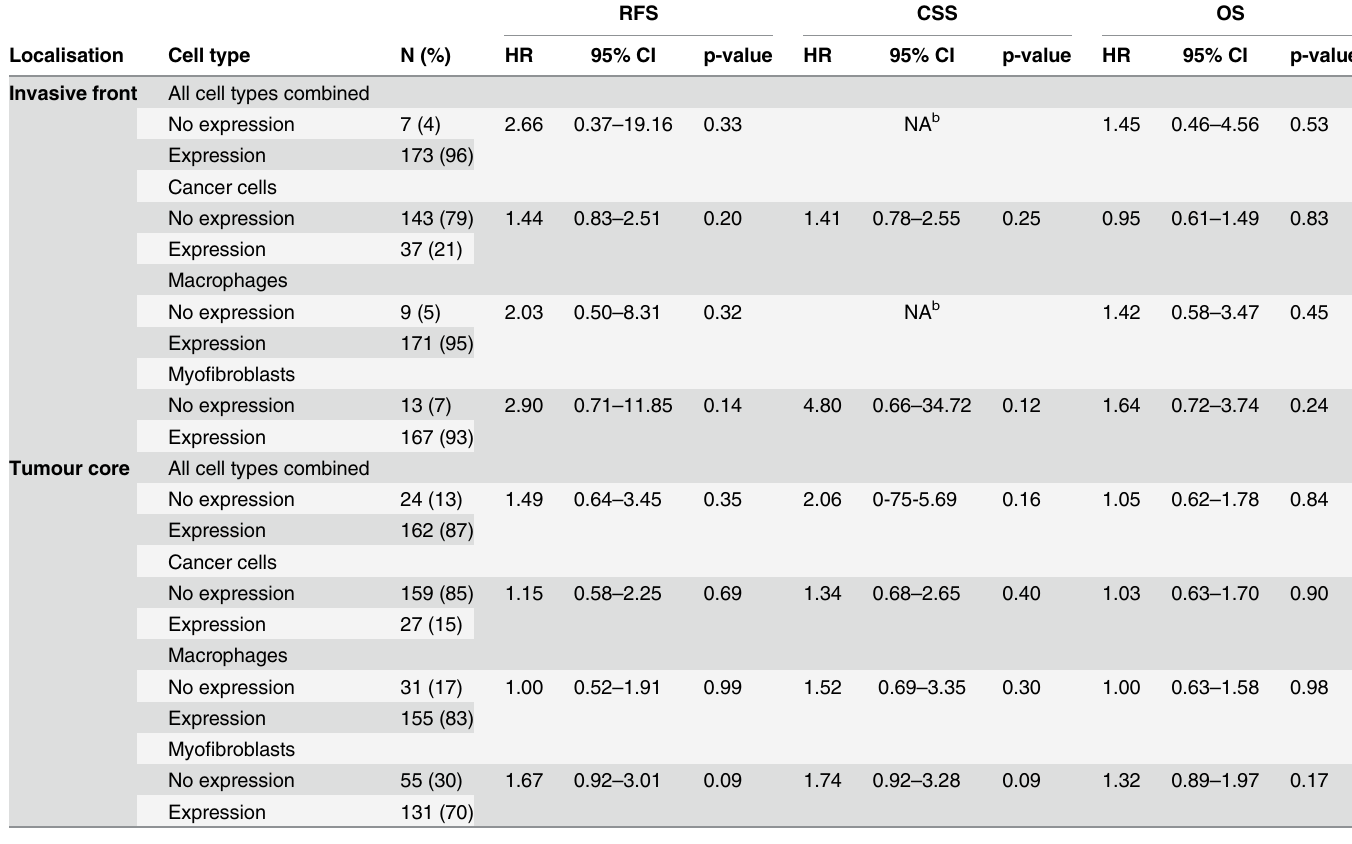
Table 2. Univariate analyses. RFS, CSS and OS by uPAR positivity (uPAR score 0 vs. > 0) a